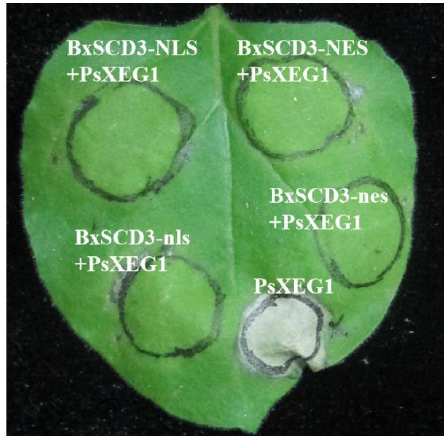
Figure 3. Whether BxSCD3 locates in the cytoplasm or the nucleus, it can suppress PsXEG1 ‐ induced cell death in Nicotiana benthamiana leaves. BxSCD3 ‐ NLS (nuclear localization signal), BxSCD3 ‐ NES (nuclear export signal), and two mutant forms, BxSCD3 ‐ nls and BxSCD3 ‐ nes, were transiently expressed in N. benthamiana leaves. The infiltration assay was performed three times and, in each assay, three different plants with three inoculated leaves were used.